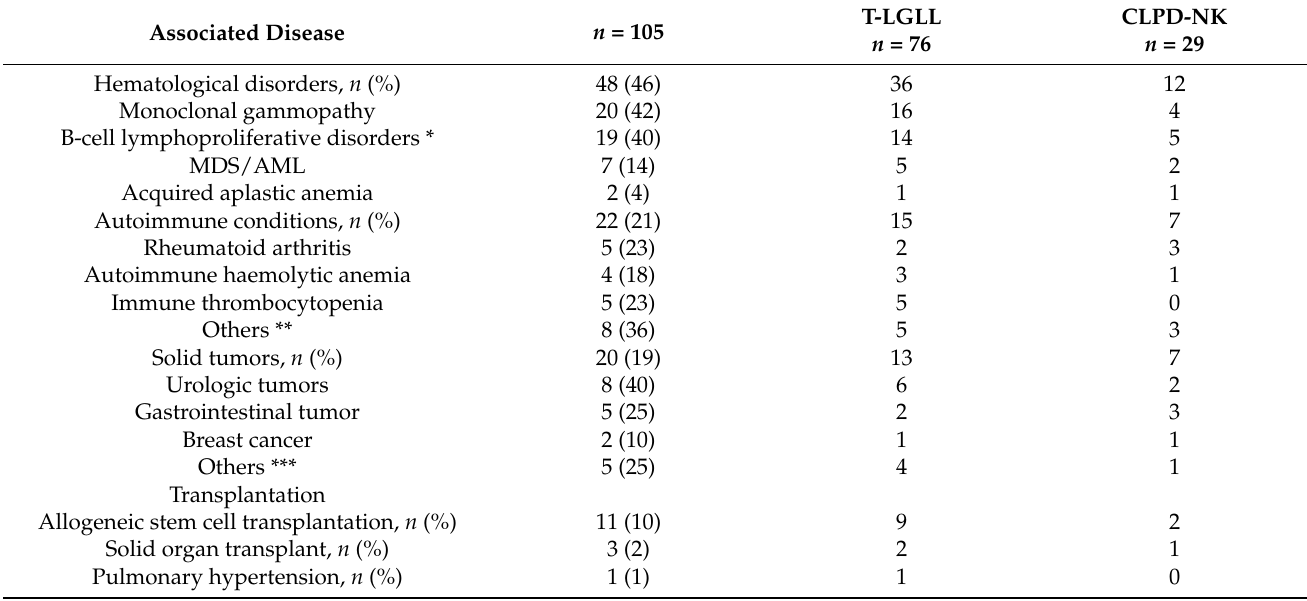
Table 2. In this case, 105 patients (80%) had diseases associated with T-LGL and CLPD-NK. Here, 105 patients had diseases associated with T-LGL and